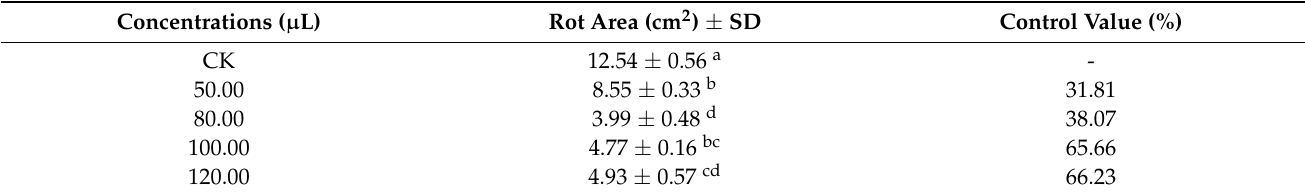
Table 3. Inhibitory effects of A.scoparia essential oil against C. gloeosporioides in vivo tests.